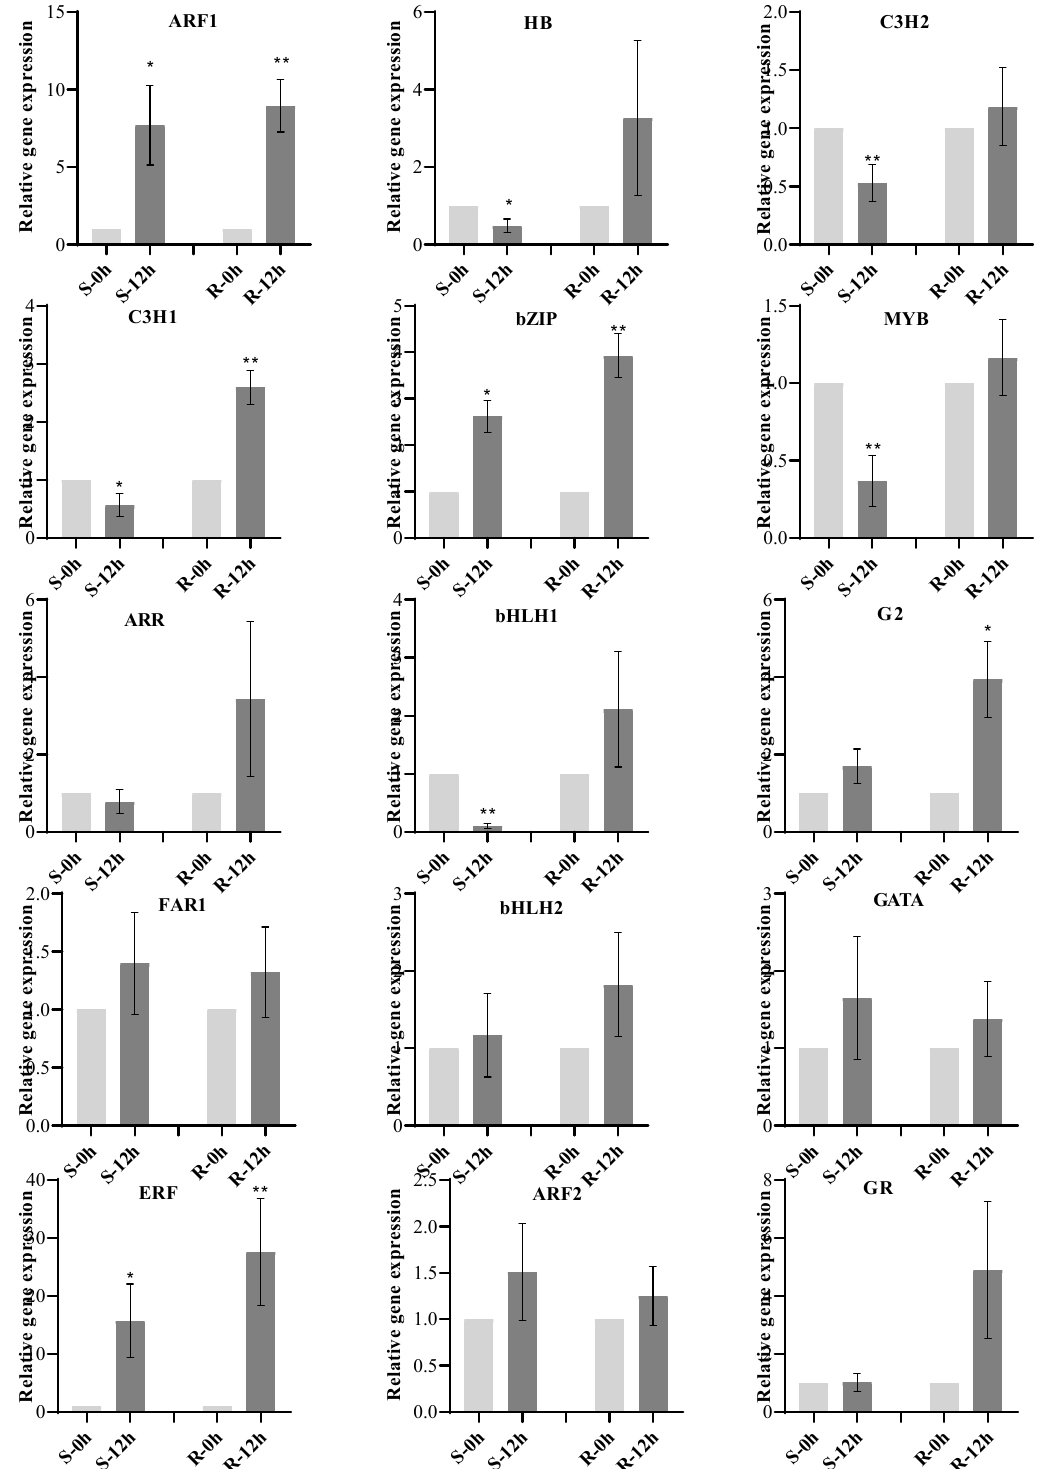
Figure 3. Expression patterns of the top 15 genes by qRT-PCR. Student’s t-test was performed to analyze the changes in the gene expres- sion 12 h after powdery mildew infection compared to 0 h in respective genotype. * and ** are statistically significant at 0.05 and 0.01 levels,